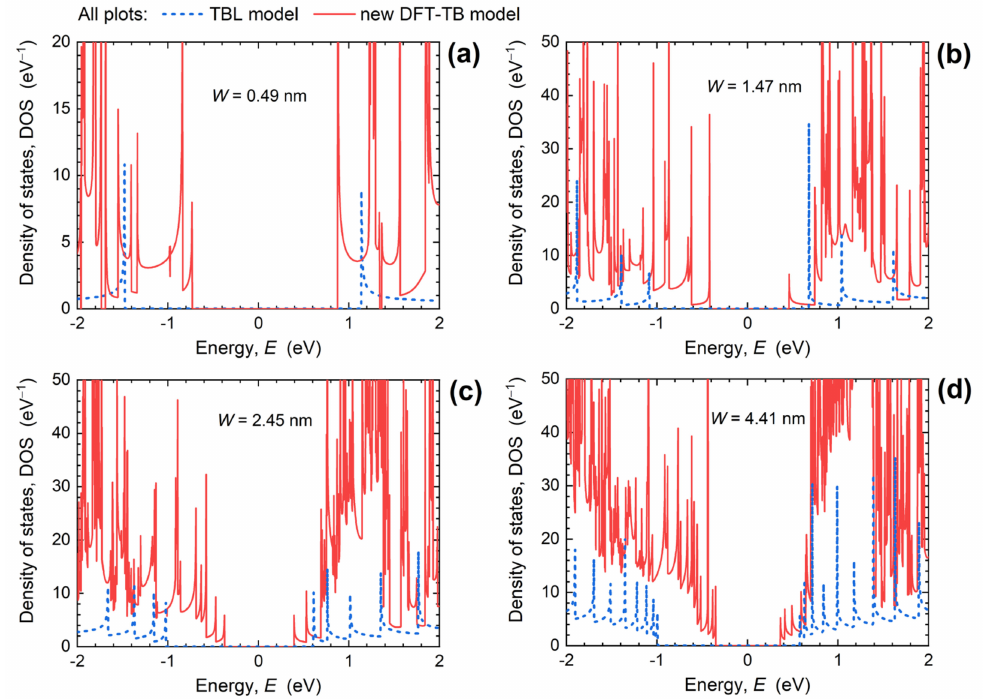
Figure 3. Density of states in PNRs obtained using the DFT-TB and TBL models for PNR widths of ( a ) 0.49 nm, ( b ) 1.47 nm, ( c ) 2.45 nm, and ( d ) 4.41